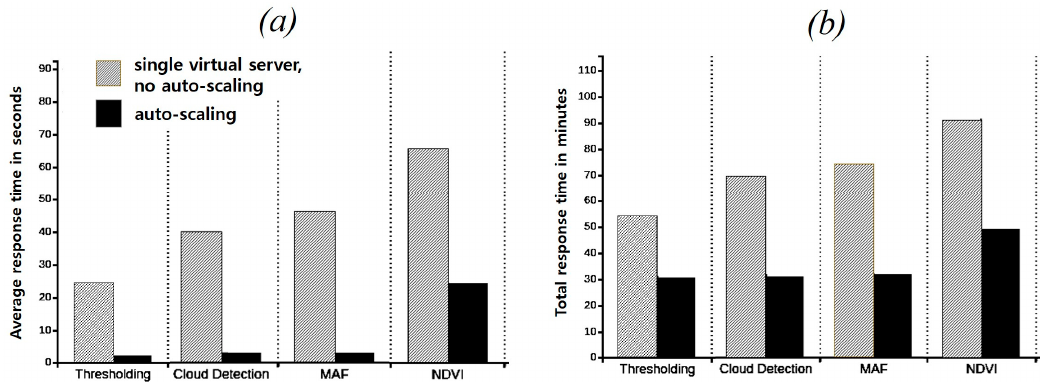
Figure 8. Experimental results for auto-scaling: ( a ) average response time; ( b ) total processing time.